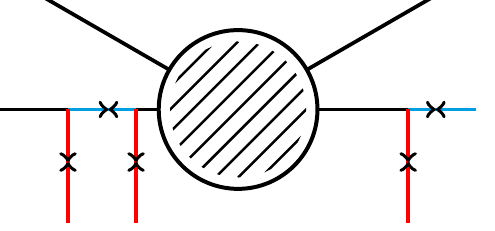
Figure 17 . Feynman diagram for three soft gravitini | II.